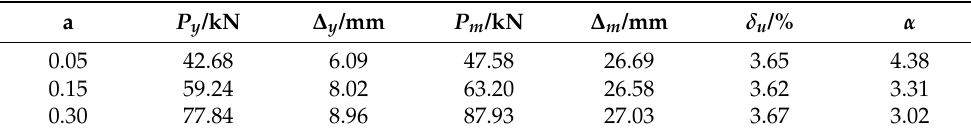
Figure 13. Hysteresis skeleton curve. Table 6. Characteristic points of skeleton curve of test piece.